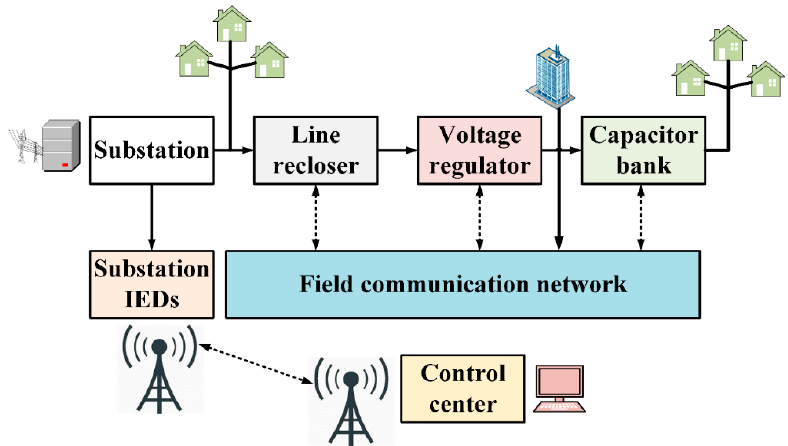
Figure 4. Operational block diagram of an advanced distribution automation system. It can monitor the system in real time and can respond automatically to the demand [45].